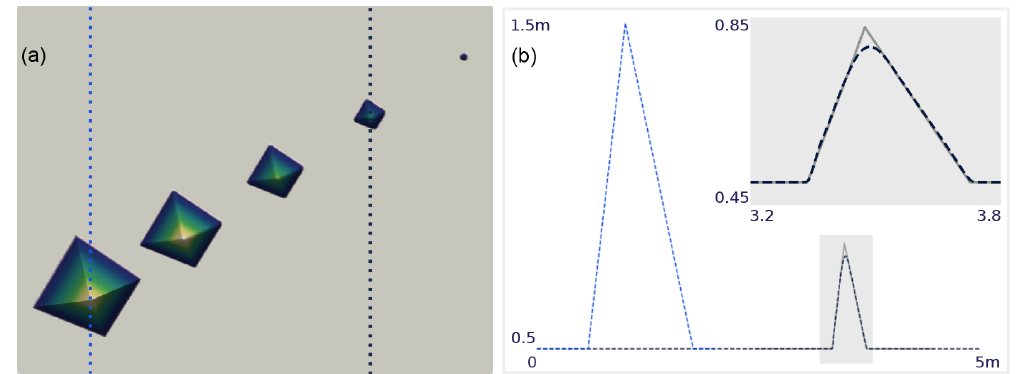
Figure 6. Pyramid translation test. Panel (a) shows the top view of the simulation results for N = 1000 at times t = 0 , 1 . 5 , 3 . 0 , 4 . 5 , 6 . 0s. Dashed vertical lines indicate the location of the respective profiles in (b) with the dashed light blue line displaying the profile at time 0s. In (b) , simulation results are shown by the dashed dark blue line and compared to the analytical solution (grey line) at time t = 4 . 5s. The inset on the right shows a zoom of the grey rectangle on the main panel.